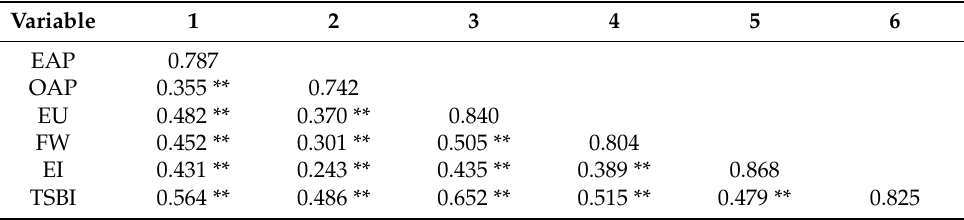
Table 3. Tests of discriminant validity.